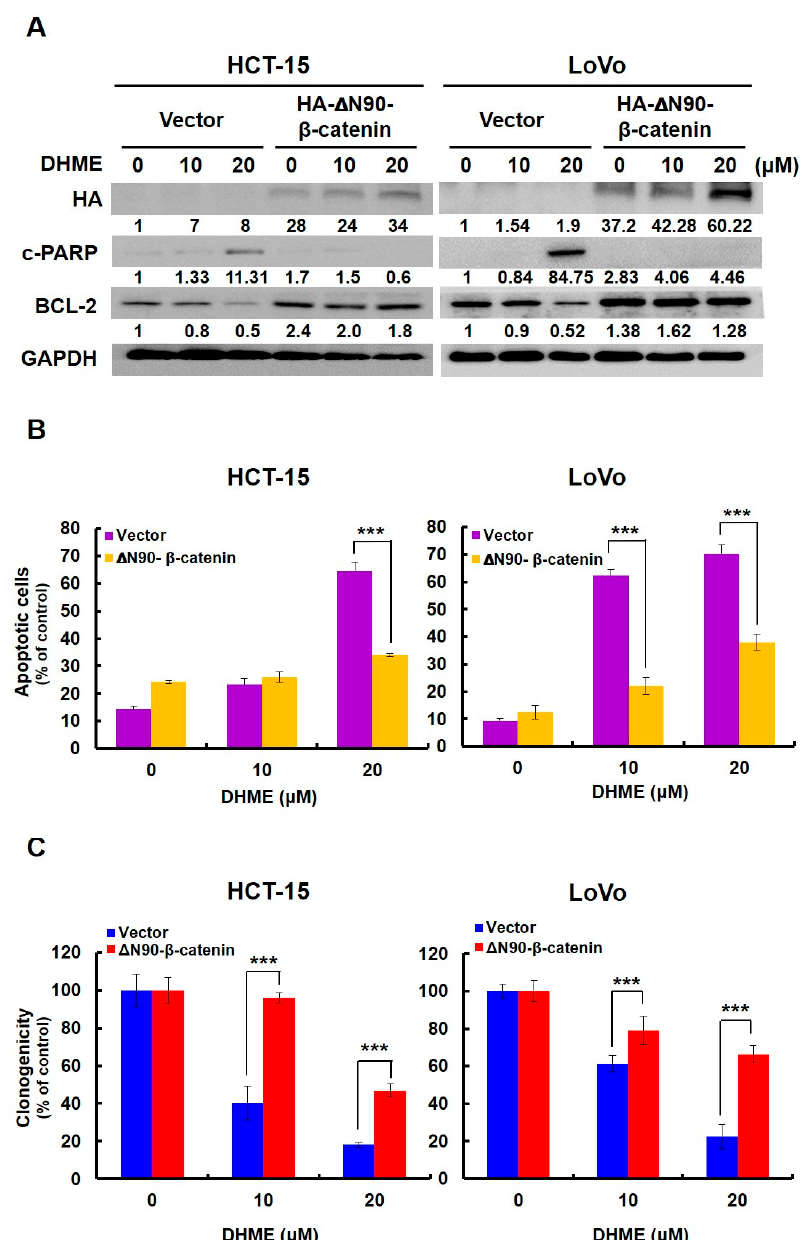
Figure 5. Blockade of WNT / β -catenin-mediated, pro-survival signaling is required for the anti-CRC action of DHME. ( A ) Persistent β -catenin activation abolishes DHME-induced PARP cleavage. HCT-15 and LoVo clones stably expressing HA– ∆ N90- β -catenin, an N-terminal, hemagglutinin (HA)-tagged, dominant-active β -catenin mutant (with N-terminal 90 amino acids deleted), were treated with DHME (0, 10, or 20 µ M) for 24 h, followed by immunoblotting for the levels of HA (confirming ectopic expression of HA– ∆ N90- β -catenin), cleaved PARP (c-PARP), and BCL-2. GAPDH levels were used as the loading control. ( B ) Persistent β -catenin activation lowers the levels of the DHME-enhanced, annexin V-positive cell population. Stable vector or HA– ∆ N90- β -catenin clones of HCT-15 and LoVo cells were treated with DHME (0, 10, or 20 µ M) for 24 h, followed by flow cytometry analysis for the levels of annexin V-positive (apoptotic) cell population. ( C ) Persistent β -catenin activation rescued DHME-mediated inhibition of clonogenicity. A total of 2 × 10 2 of stable vector or HA– ∆ N90- β -catenin clones of HCT-15 and LoVo cells after 24 h treatment of DHME (0, 10, or 20 µ M) were assessed for their ability to form colonies. The levels of protein-to-GAPDH ratio relative to DHME-untreated vector controls were quantitated by ImageJ algorithm and are indicated below each blot. *** p <